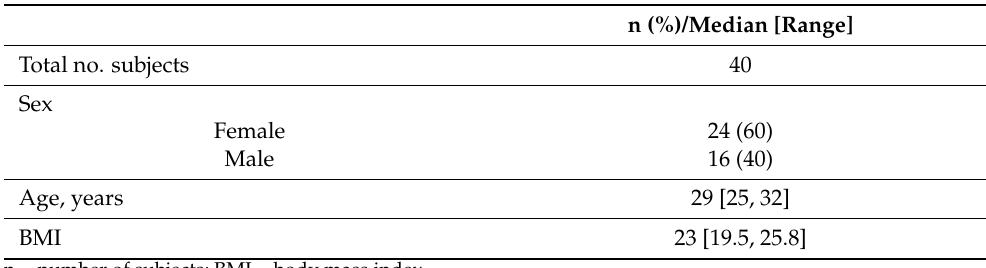
Table 1. Descriptive data of the healthy subjects group.